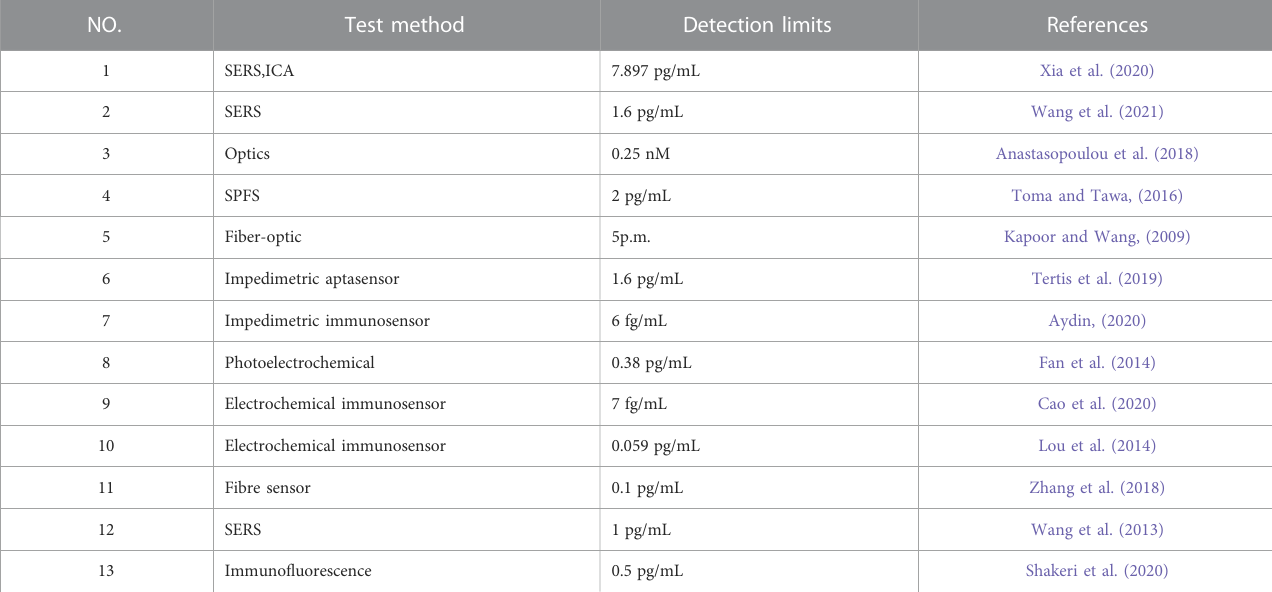
TABLE 1 Different methods to detect IL-6.